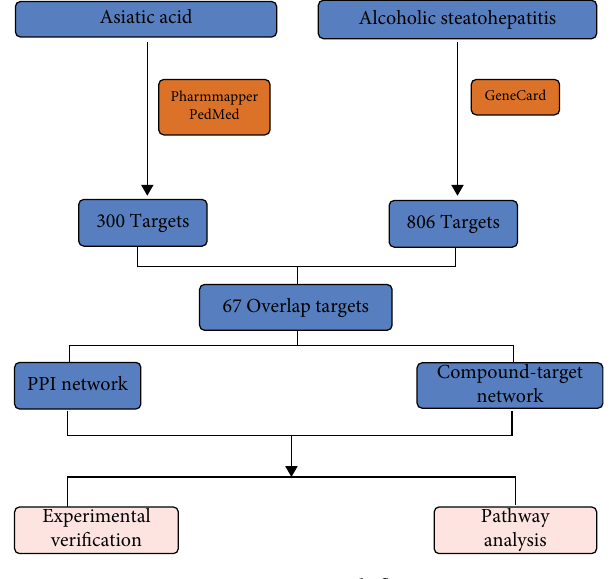
Figure 1: Research fl